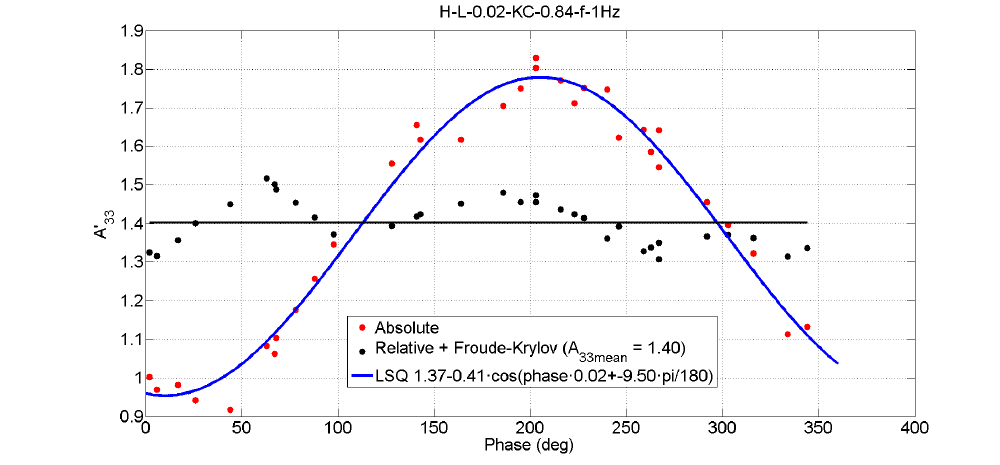
Figure 6. Added mass coefficient vs. phase angle for H / L = 0.02, KC = 0.84.